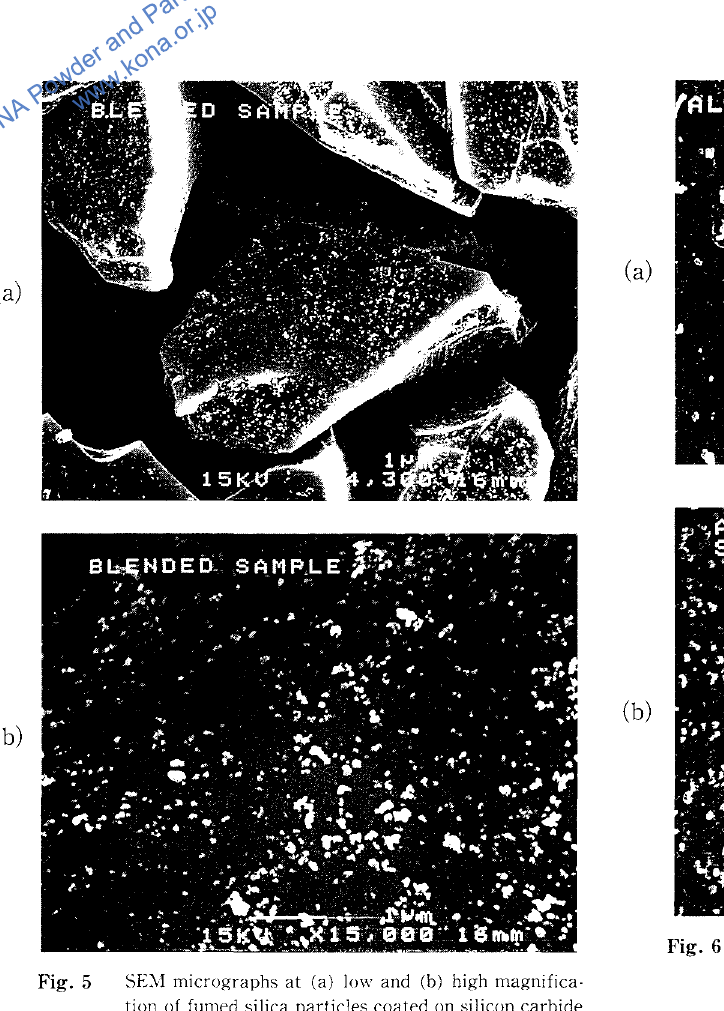
SE:VI micrographs at (a) low and (b) high magnifica